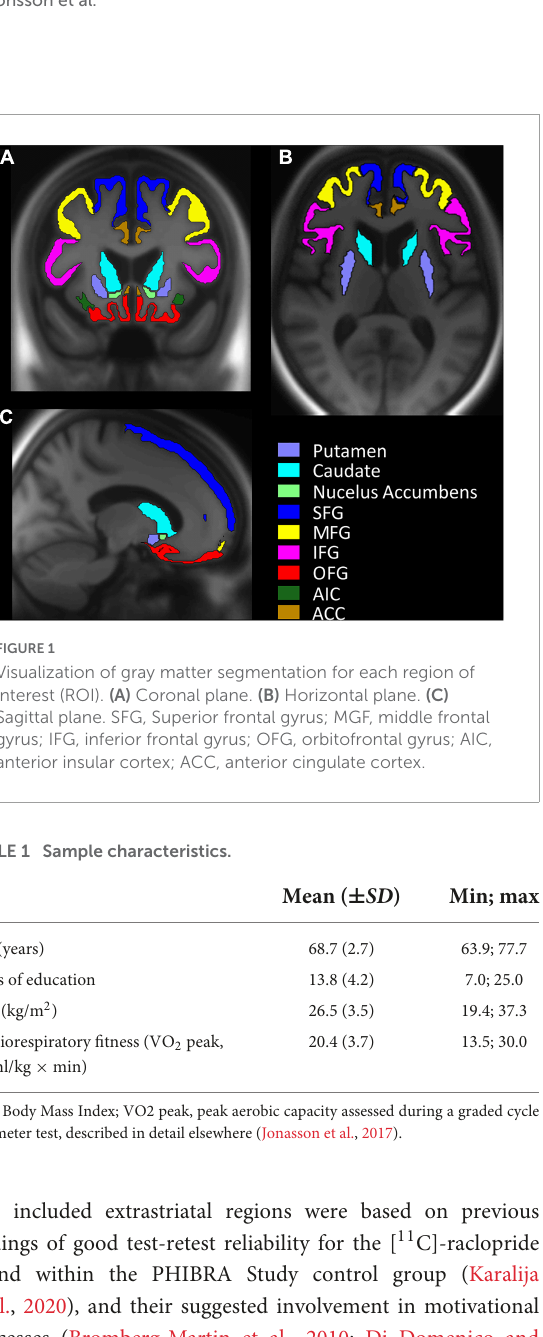
Figure 1 for scatterplots of autonomous motivation and raw BP ND data), adjusting for ROI-volume, age, and